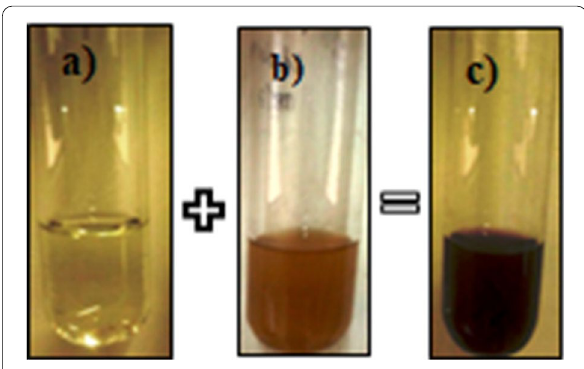
Fig. 3 a Chloroauric acid, b plant extracts, c synthesized AuNPs. a Precursor solution (chloroauric acid, the standard component = in synthesis). b Plant extracts (variable component, each plant = extract resulted in different nanoparticles). c Synthesized gold = nanoparticles (different nanoparticles were synthesized due to different reducing agents, plant extracts)